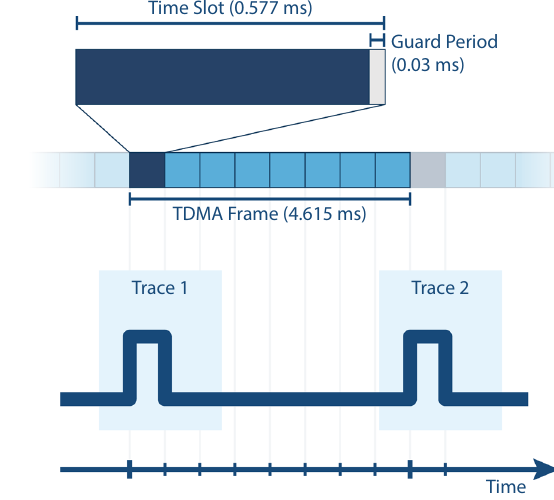
schematic of the time trace of a GSM signal triggered in one detector channel. The time structure of the corresponding GSM signal is indi- cated